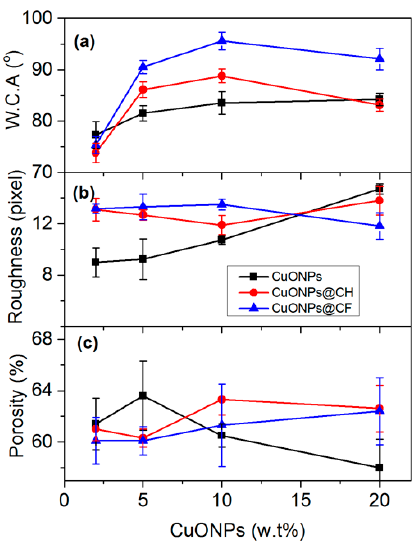
Figure 4. Variation of ( a ) WCA, ( b ) membrane surface roughness, and ( c ) film porosity with varying nanoparticle types and concentrations.